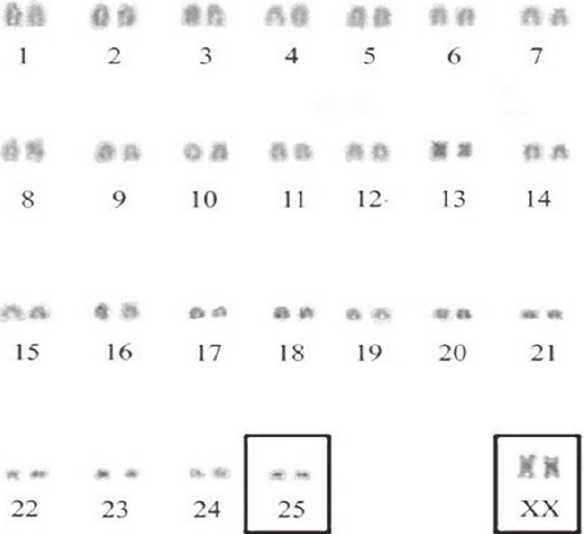
Figure 2. Karyotype of Rhogeessa hussoni (2n = 52 and NF = 54). The highlighted box shows respectively the chromosome pair 25, with rDNA sites, and sex chromosomes.